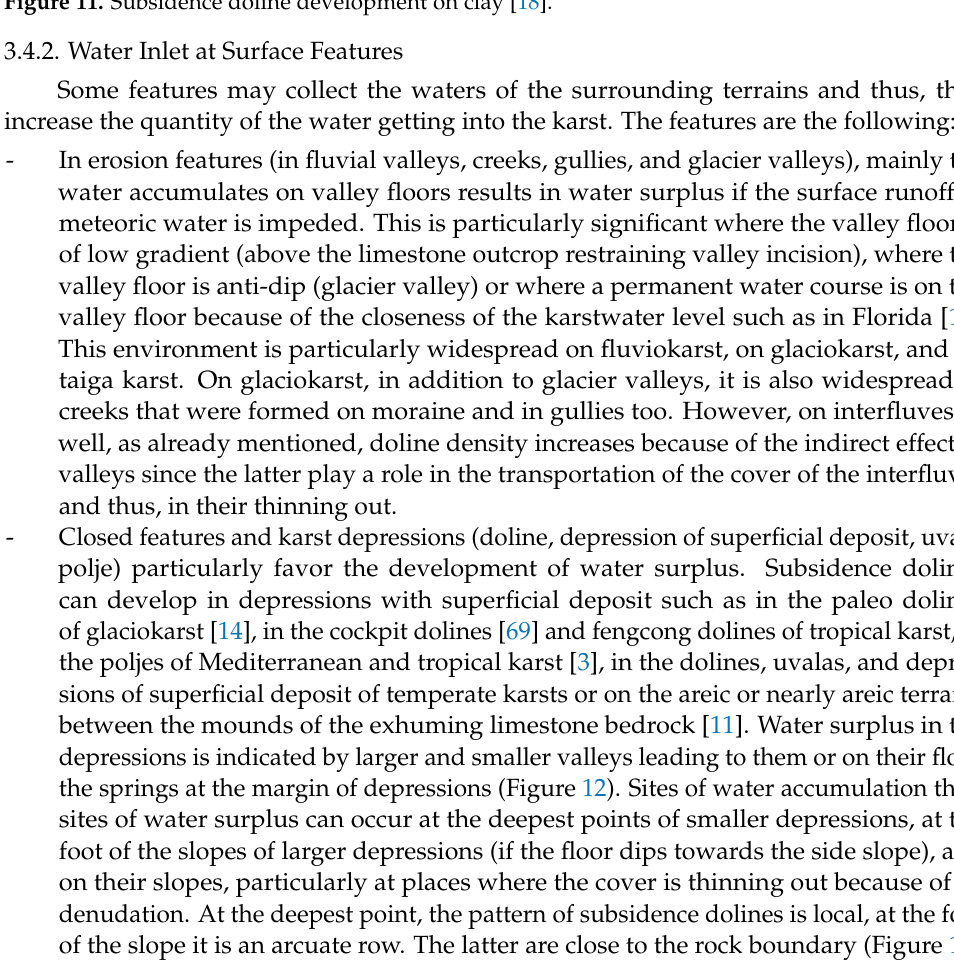
Figure 11. Subsidence doline development on clay